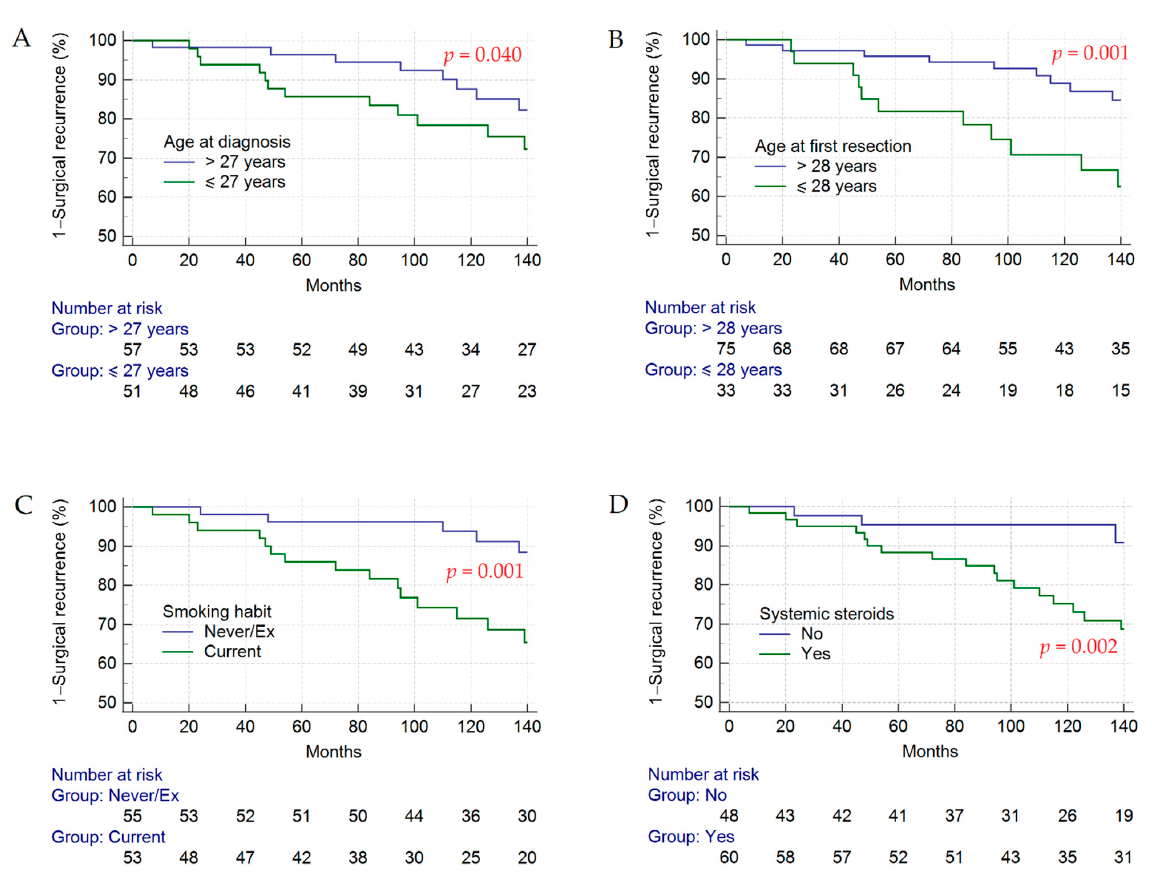
Figure 2. Cumulative surgical recurrence rates calculated using the Kaplan–Meier method. At the median FU of 136.5 months, the 82.2% of patients with age > 27 years at CD diagnosis was surgical recurrence-free, compared to the 75.5% of patients with age ≤ 27 years at CD diagnosis ( A ), the 84.6% of patients with age > 28 years at first surgery was surgical recurrence-free as compared to the 66.7% of patients with age ≤ 28 years at first surgery ( B ), the 90.1% of former/never smokers was surgical recurrence-free as compared to the 68.7% of current smokers ( C ), and the 92.7% of patients that did not receive systemic steroid therapy was surgical recurrence-free as compared to the 70.9% of pa- tients administered with systemic steroid therapy ( D ). Table 2. Univariate and multivariate Cox regression analysis of factors associated to surgical recur- rence. Variables